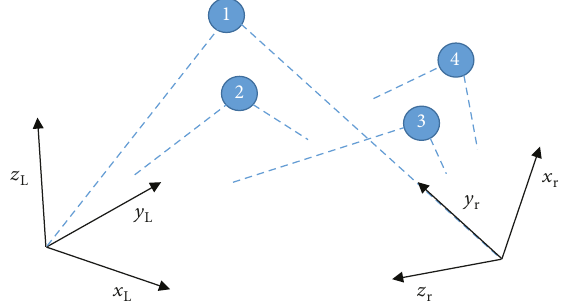
Figure 31: The coordinates of a number of points is measured in two di ff erent coordinate systems. The transformation between the two systems is to be found. Adapted from [49].